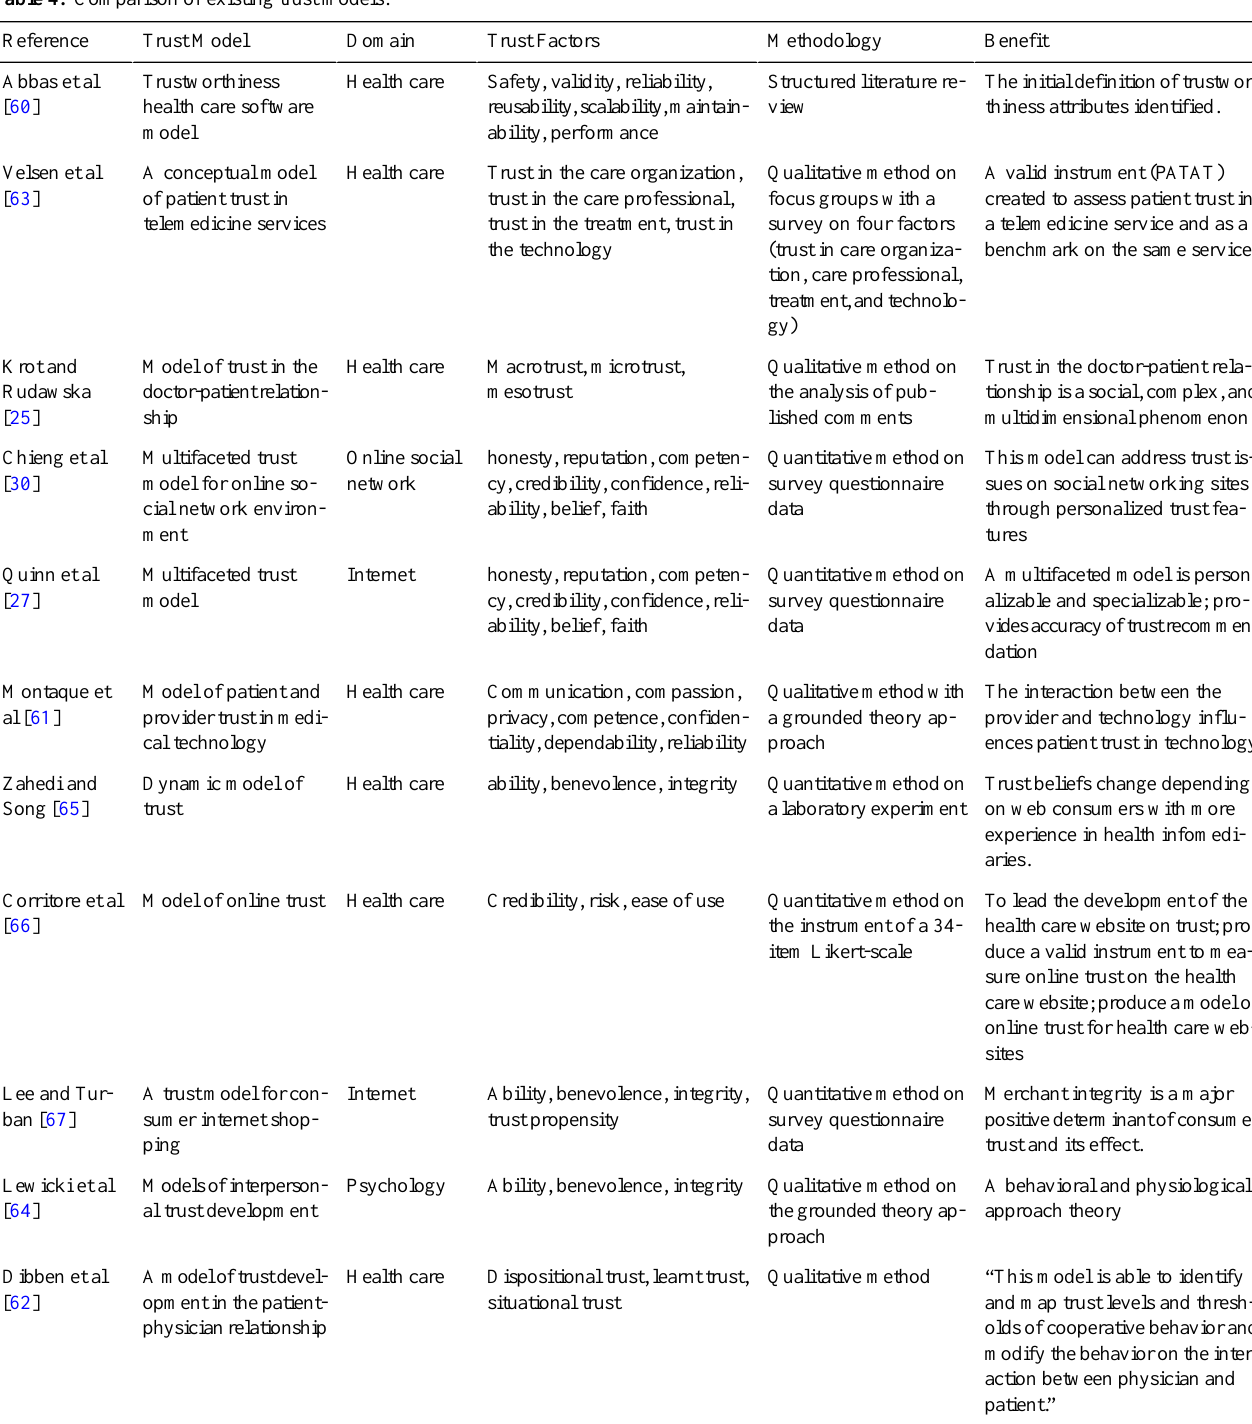
Table 4. Comparison of existing trust